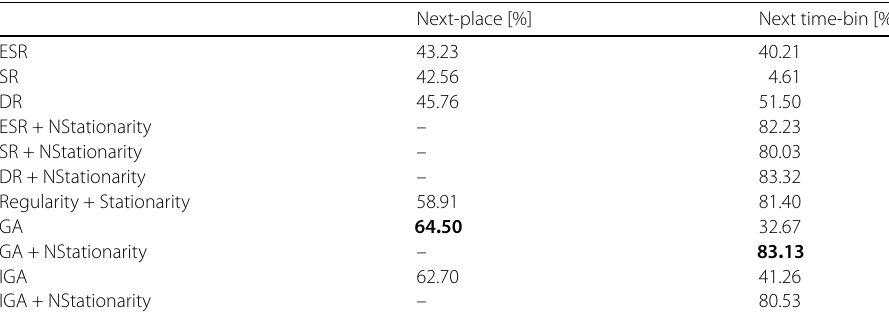
Next-place [%] Next time-bin [%]